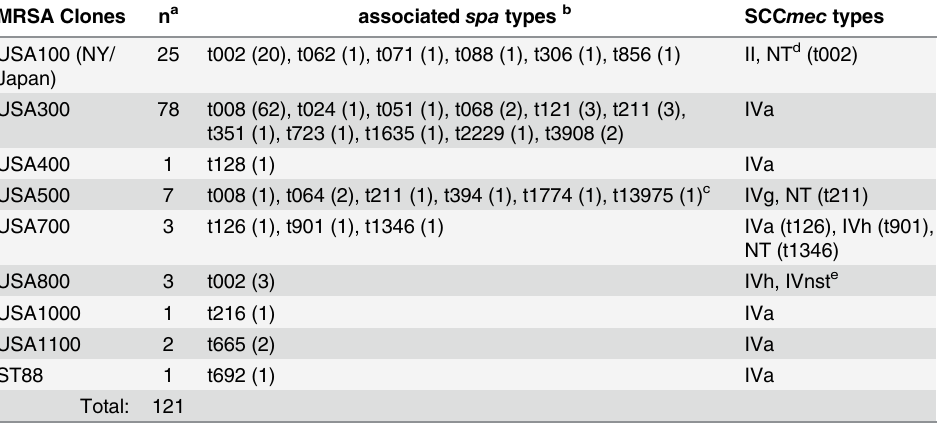
Table 3. Distribution of MRSA clones and the different spa types and SCCmec types identified in this